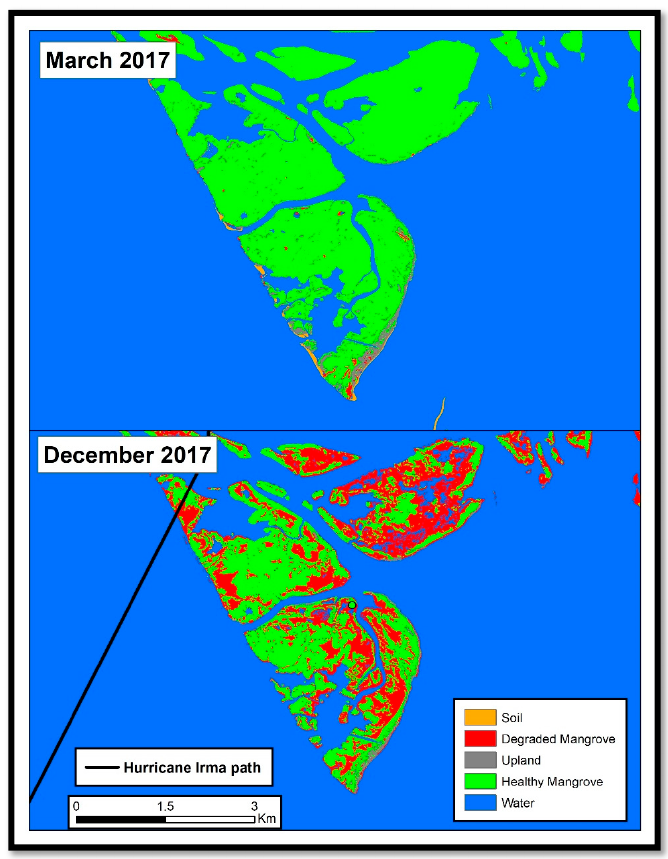
Figure 5. Damage to mangroves caused by Hurricane Irma in September 2017.